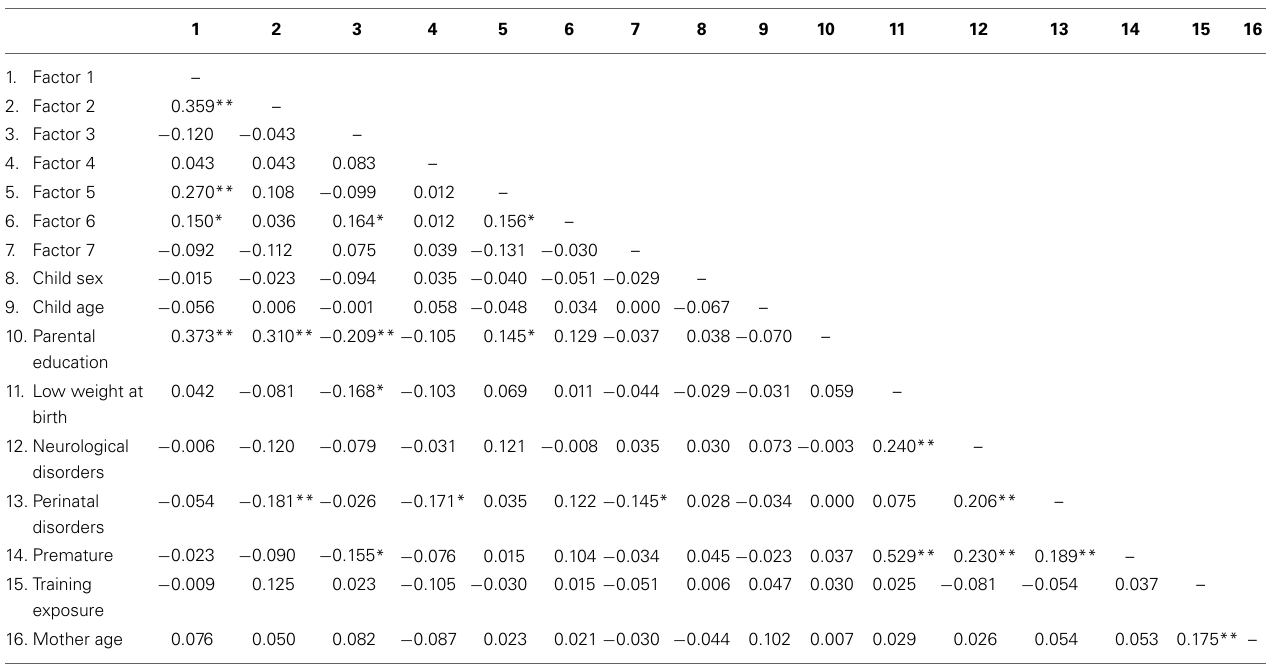
Table 13 | Correlations for independent variables in the CTP.